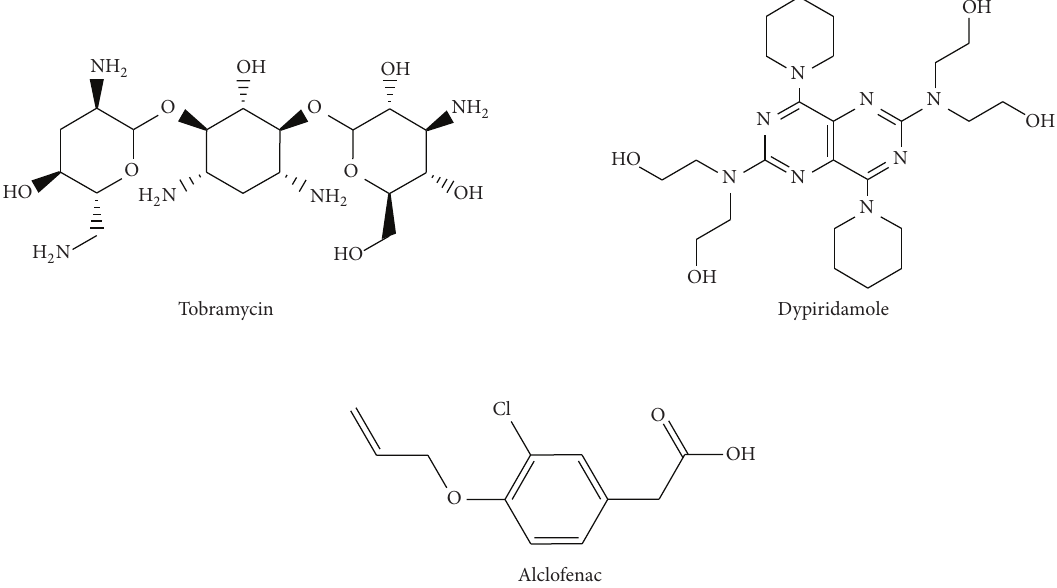
F 4: Example of molecules conforming training and test set, having differences in the presence of saturated alicyclic or aromatic rings and, hence, determining dyspnea side